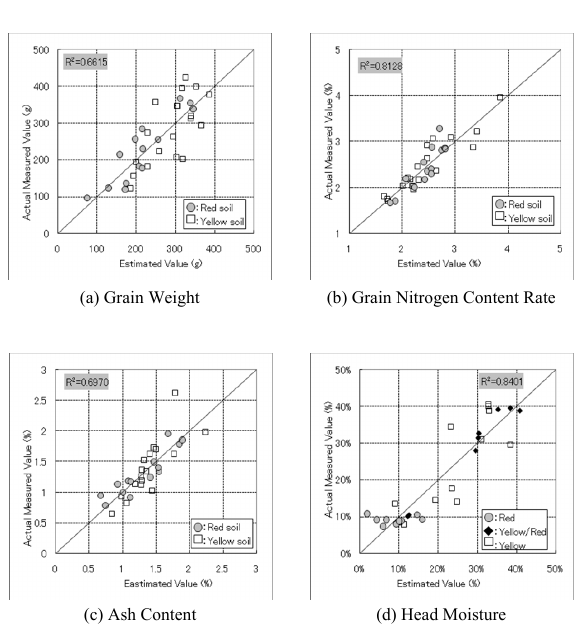
Figure 6: Comparison Results of Estimated and Actual Measured